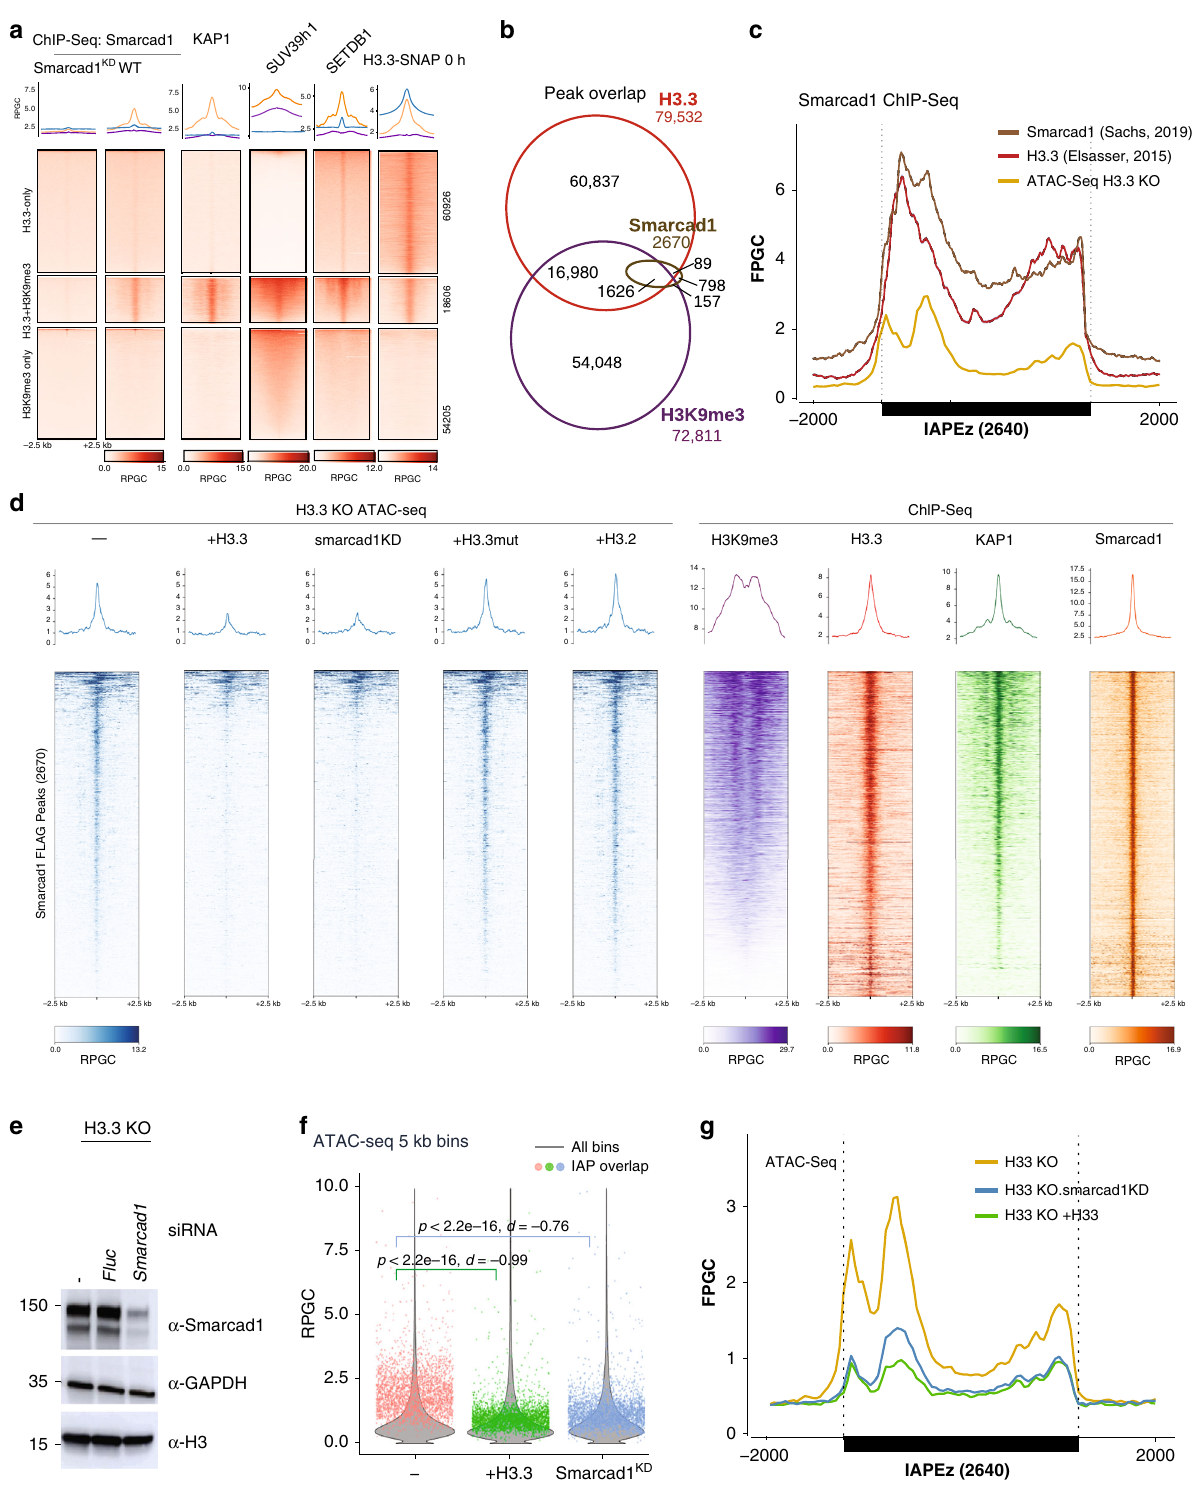
negligible in WT cells, and H3.3 expression in H3.3 KO cells,